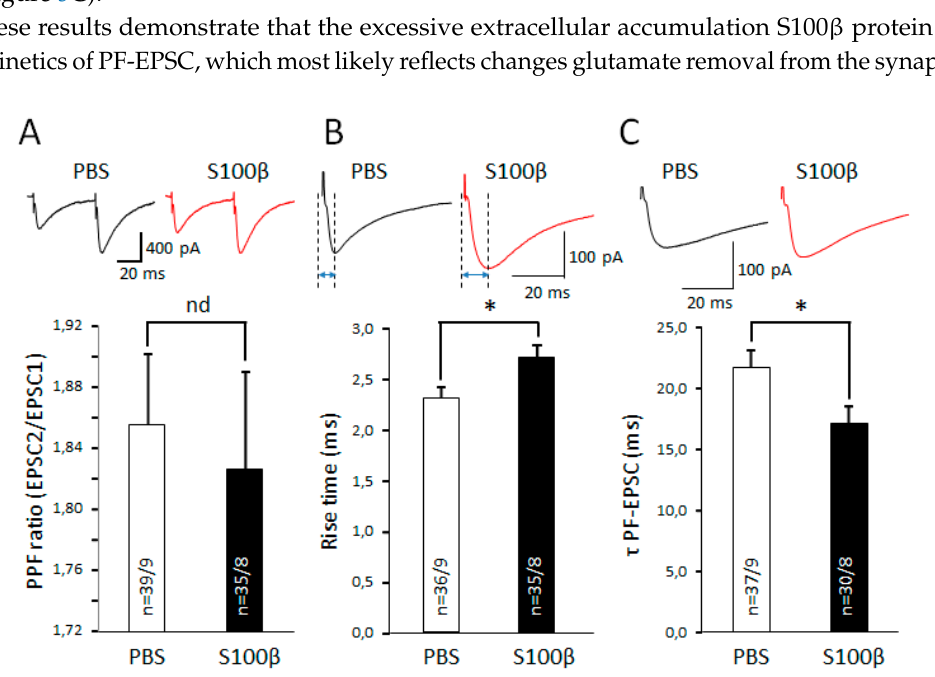
Figure 5. Alters PCs’ electrophysiological properties. ( A ) The summary graph shows the average PPF ratio (second amplitude/first amplitude EPSC) in PCs from PBS and S100 β injected areas, no significant differences found. Below—representative traces of parallel fibre (PF)-EPSCs. ( B ) The summary graph shows the average rise time of PF-EPSCs in PCs from PBS and S100 β injected areas. In comparison with PBS-injected areas, rise time was significantly longer in S100 β injected areas. Representative traces of PF-EPSCs are shown above. ( C ) In comparison with PBS-injected areas, the decay time was significantly longer in S100 β injected areas. The represented traces of PF-EPSCs are shown above. * p < 0.05.